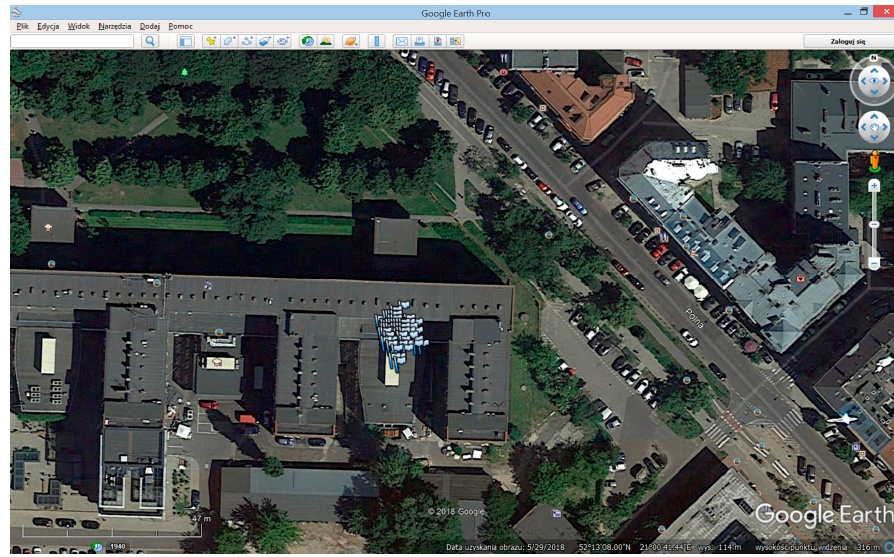
Figure 18. Position calculation using GNSS-ISE. Table 2. Comparison with published multi-constellation and multi-frequency GNSS